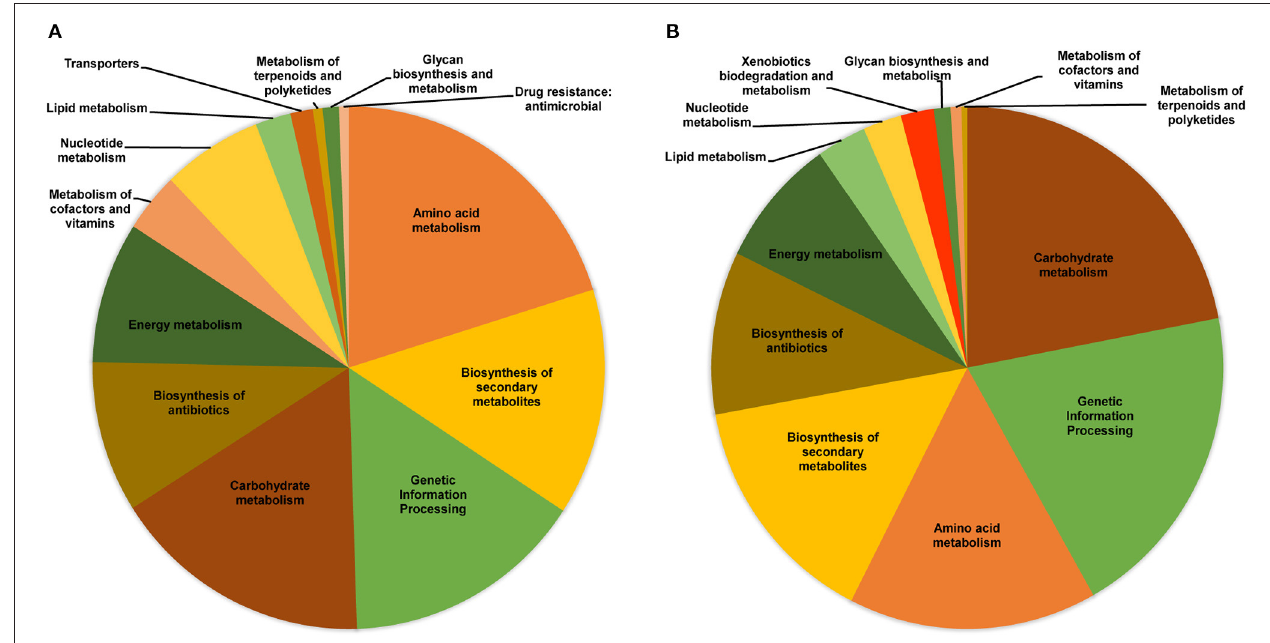
FIGURE 5 | General functional classification base on KEGG annotations of metaproteome data. (A) Bacteria proteins. (B) Fungi